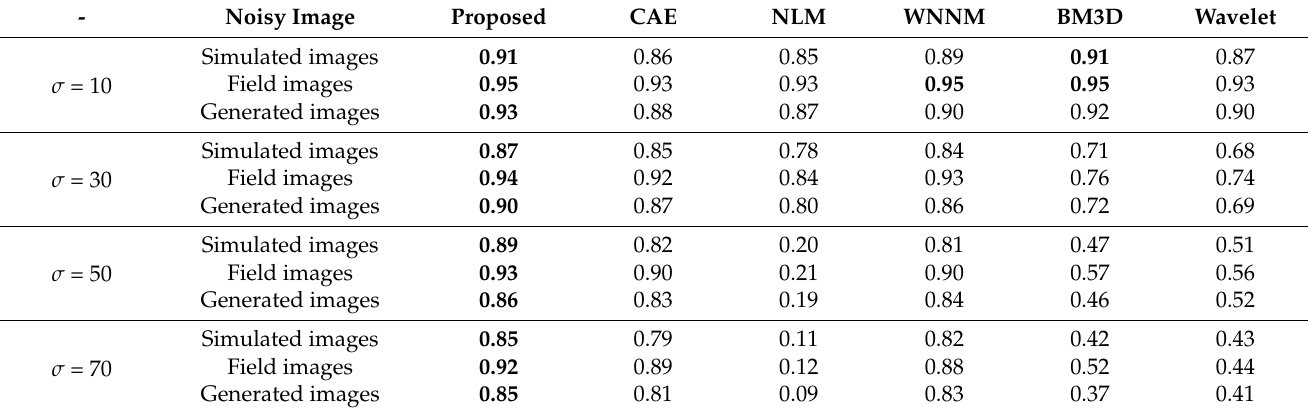
Table 2. Average SSIM for different standard deviations with various denoising methods.